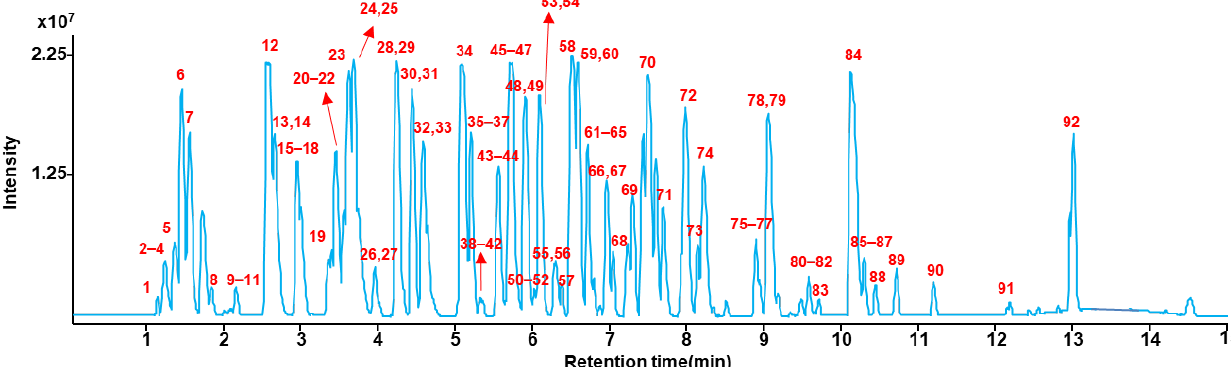
Figure 4. Total ion chromatogram of 92 illegal adulterants under optimized LC-MS conditions in positive ion mode.